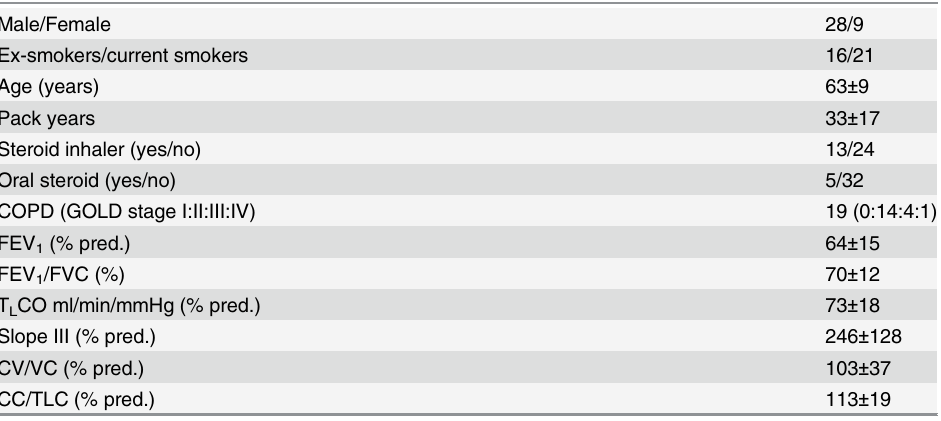
Table 2. Patient